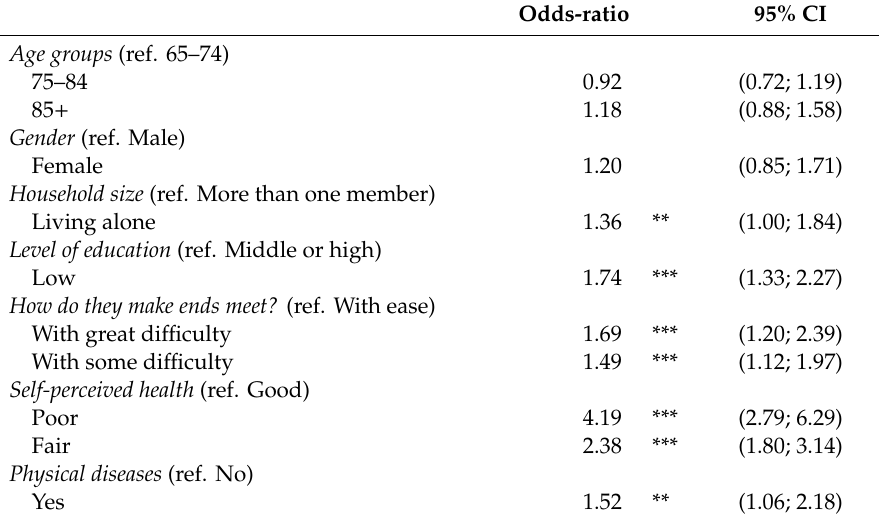
Table 2. Logistic regression model for the SWEMWBS indicator (1 = low; 0 = normal). Odds-ratio 95%